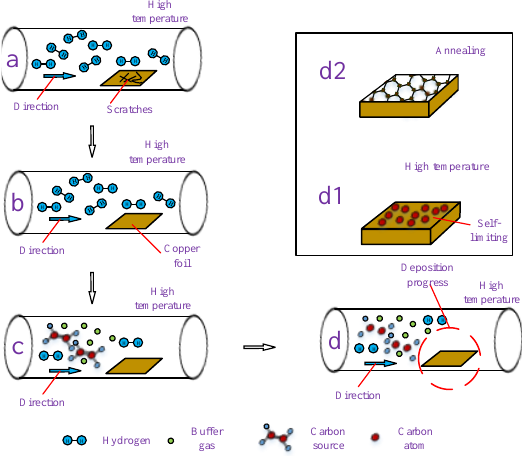
Figure 5. Mechanism of CVD growth graphene on Cu: ( a ) before etching; ( b ) after etching by hydrogen; ( c ) introducing buffer gas and carbon source; ( d ) synthesis process; ( d1 ) before annealing; ( d1 ) after annealing. ( d2 ) after